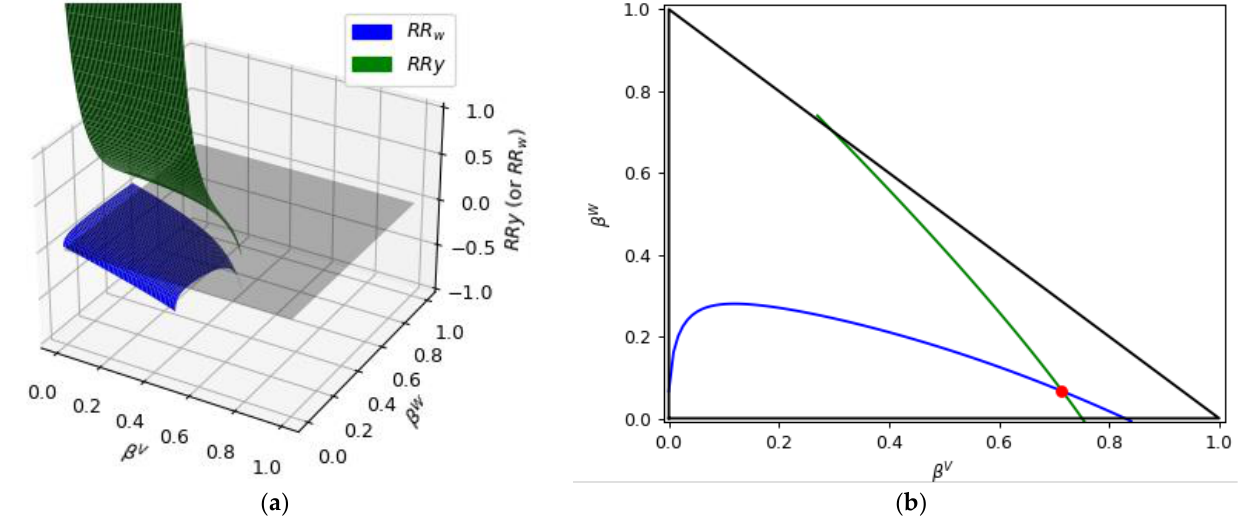
Figure 7. ( a ) RR y and RR w surfaces intersecting the z = 0 plane highlighted in grey (Adapted Figure 7. ( a ) 𝑅𝑅 𝑦 and 𝑅𝑅 𝑤 surfaces intersecting the z = 0 plane highlighted in grey (Adapted from from [29]), ( b ) The β V and β w lines at z = 0 plane. Note: The “red dot” represents the solution at [29]), ( b ) The 𝛽 𝑉 and 𝛽 𝑤 lines at z = 0 plane. Note: The “red dot” represents the solution at 𝑅𝑅 𝑦 = RR y = 0 and RR w = 0 0 and 𝑅𝑅 𝑤 = 0 plane.